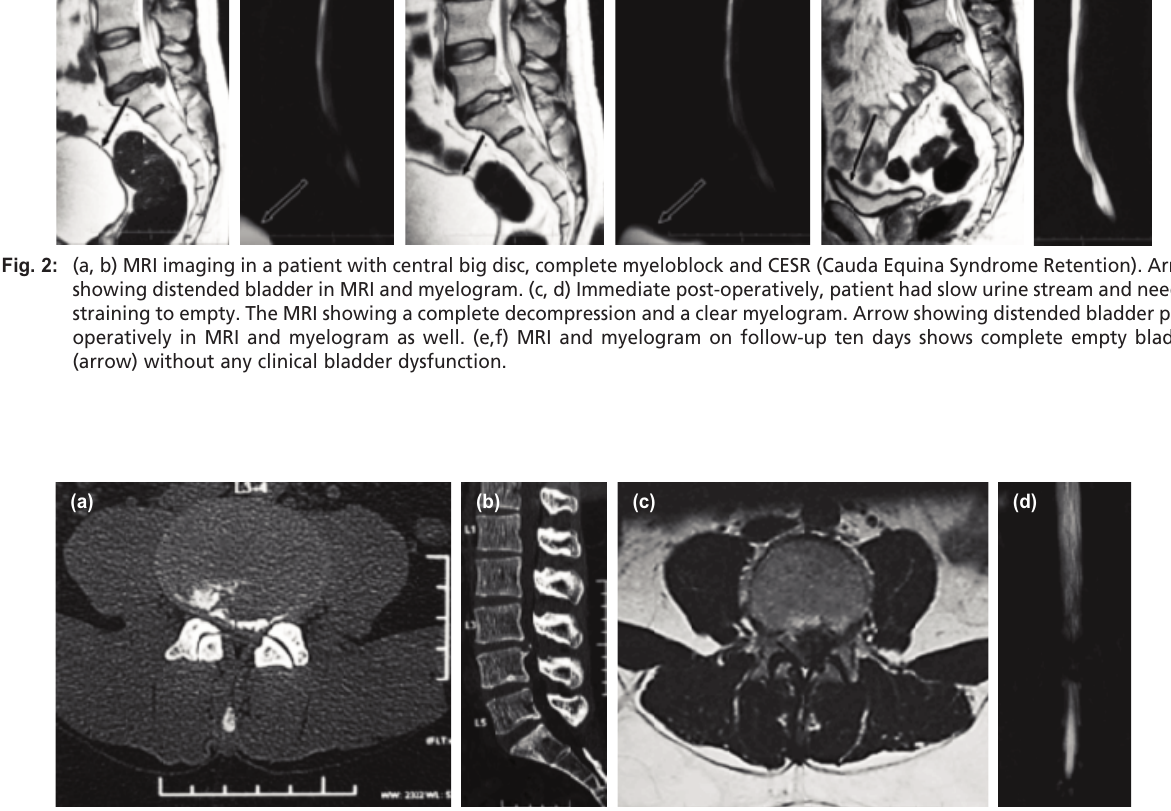
(a) Pre-operative CT (Computed Tomography) scan axial (b) and sagittal, (c) axial MRI in a 23-year-old male patient of CES with Fig. 3: bilateral leg affection and vesicular dysfunction showing a calcified central LDH (Lumbar Disc Herniation). (d) MRI myelogram showing complete